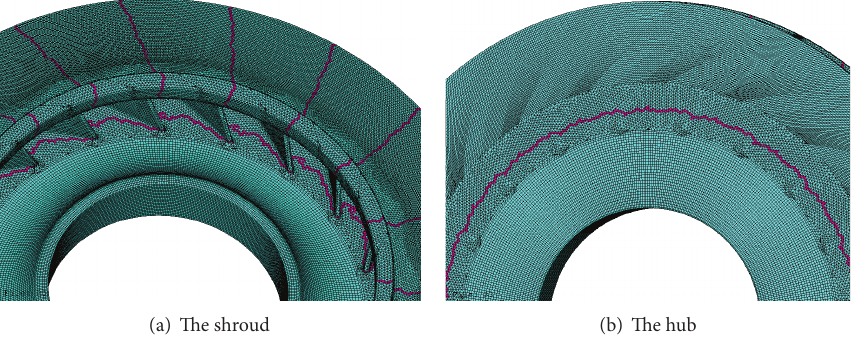
Figure 15: Impeller final fracture mode (𝑛𝑚 = 2500) .